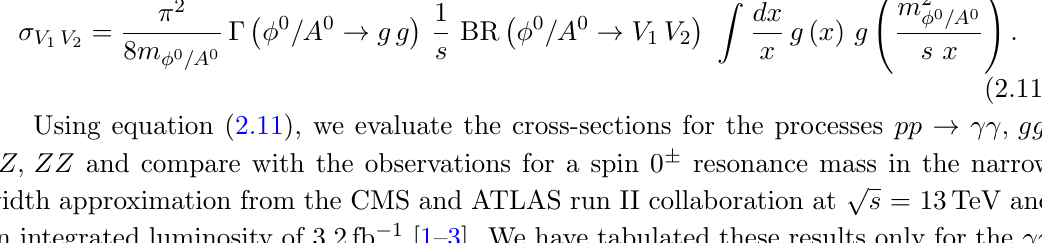
Figure 4. Three band of contours showing the 2 (cid:27) limits on the coupling in the m (cid:0) y plane, w.r.t. the central value of the di-photon production cross-section as observed at from the CMS and ATLAS collaborations in Run 2 [1{3] corresponding to the three scalar/ pseudo- scalar masses 270, 500 and 750 GeV respectively. The left and right panels are for the scalar and pseudo-scalar panels